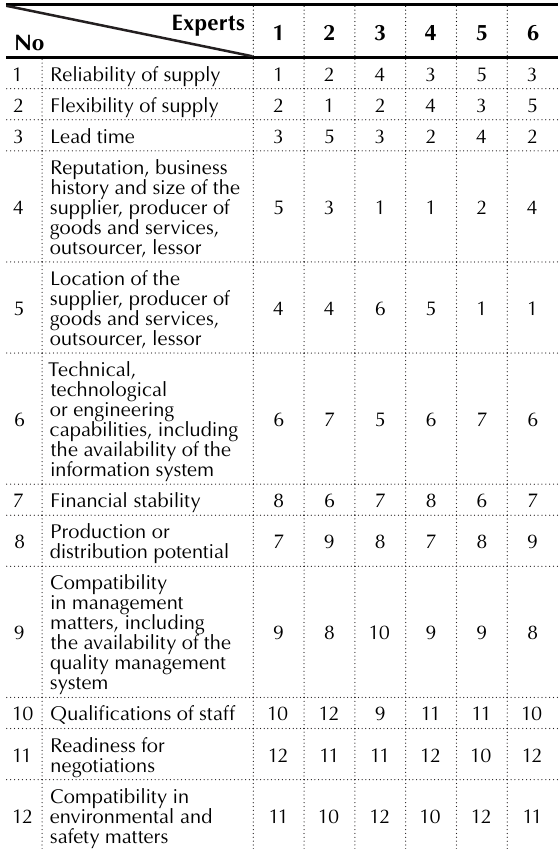
Table 5. Overall matrix of